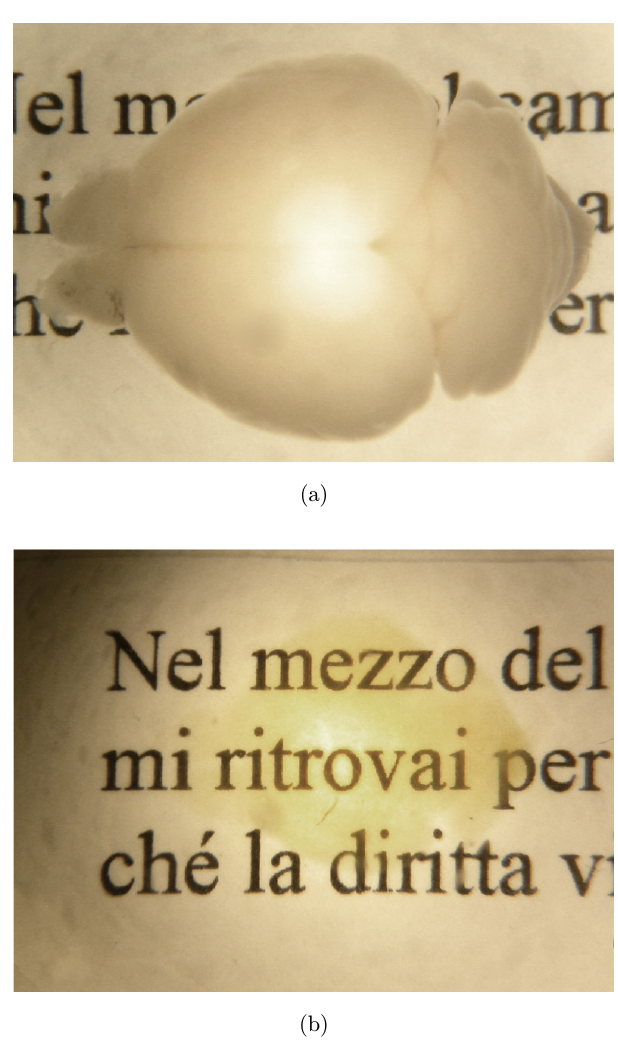
Fig. 2. Optical clearing through refractive index matching. A mouse brain before (a) and after (b) optical clearing by sub- stitution of water with a mixture 1:2 of Benzyl Alcohol and Benzyl Benzoate.